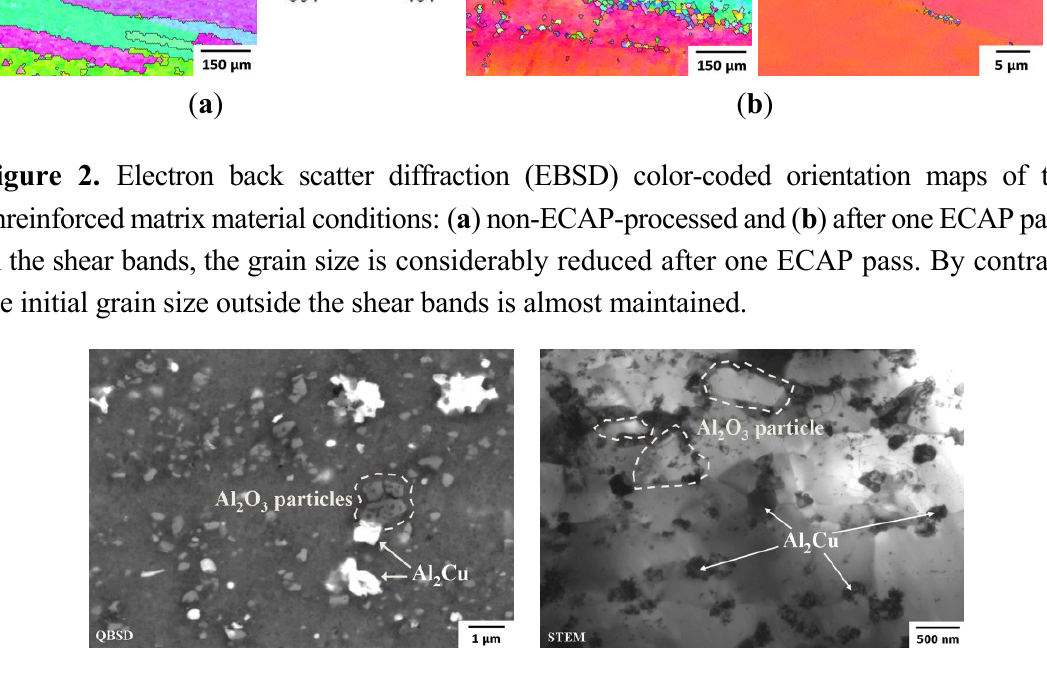
Figure 3. Quadrant backscatter diffraction (QBSD, left ) and scanning transmission electron microscopy (STEM, right ) micrographs of Al 2017 with 5 vol % Al 2 O 3 particles with a size of 0.2–2 µm. Al 2 O 3 particles are marked with broken lines and the Al 2 Cu precipitates with arrows. The particles are finely dispersed and matrix and particles exhibit an intact interface.